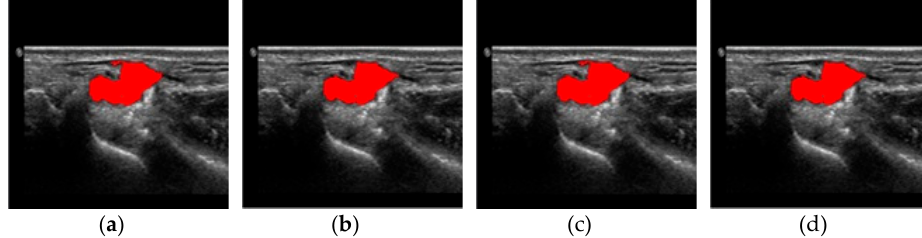
Figure 11. Comparison of final cyst extractions: ART2 vs. FCM. ( a ) Case 1 (ART), ( b ) proposed, ( c ) Case 2 (ART), ( d ) proposed.